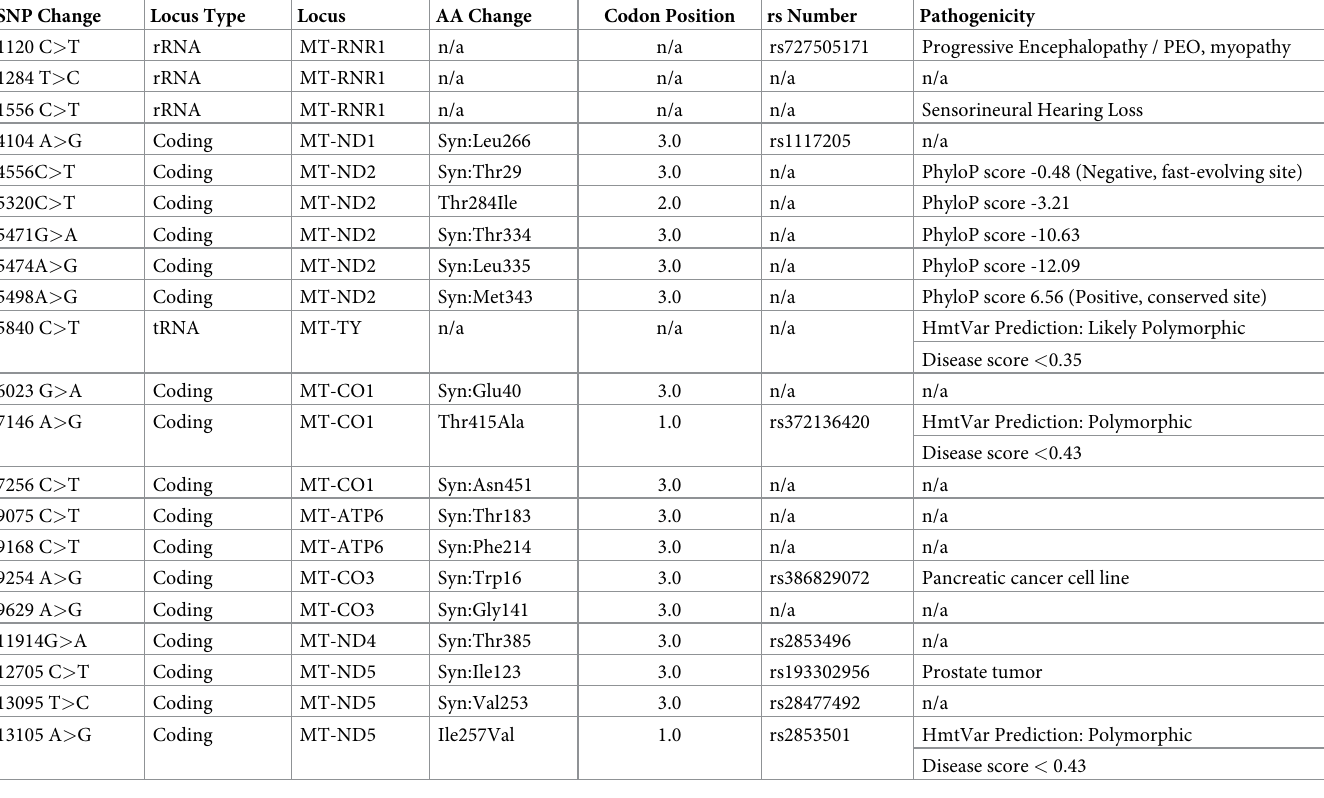
Table 7. Characterization and pathogenicity of 15 heteroplasmy